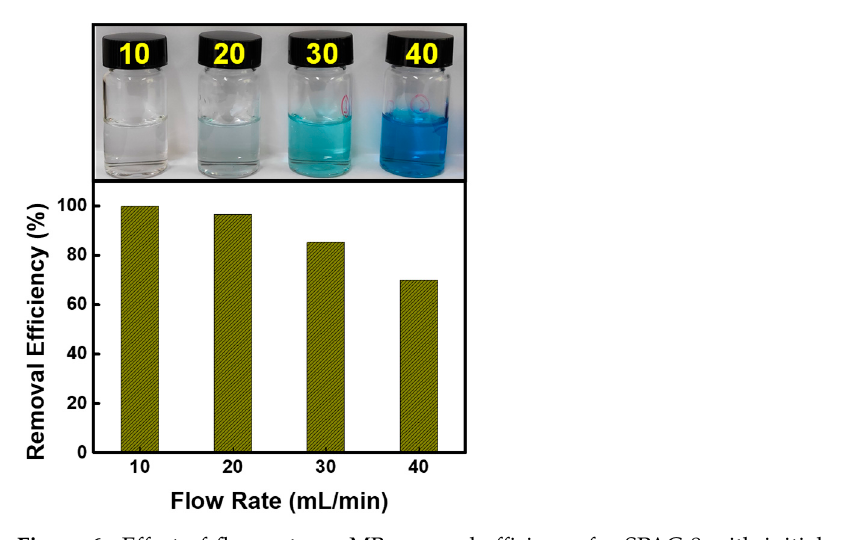
Figure 6. Effect of flow rate on MB removal efficiency for SPAC-8 with initial concentration of 50 mg/L, solution volume of 10 mL and adsorbent dosage of 5 mg.